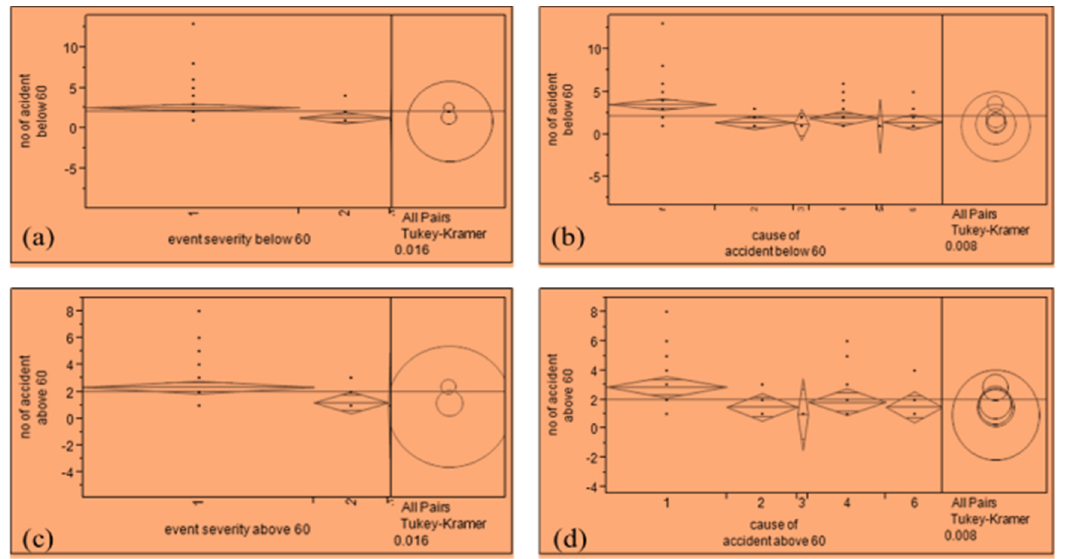
FIG.6: MODIFIED BONFERONI TEST FOR AGE ABOVE AND BELOW 60 YEARS a) EVENT SEVERITY ABOVE 60 b & c) CAUSE OF ACCIDENT BELOW 60 d) CAUSE OF ACCIDENT ABOVE